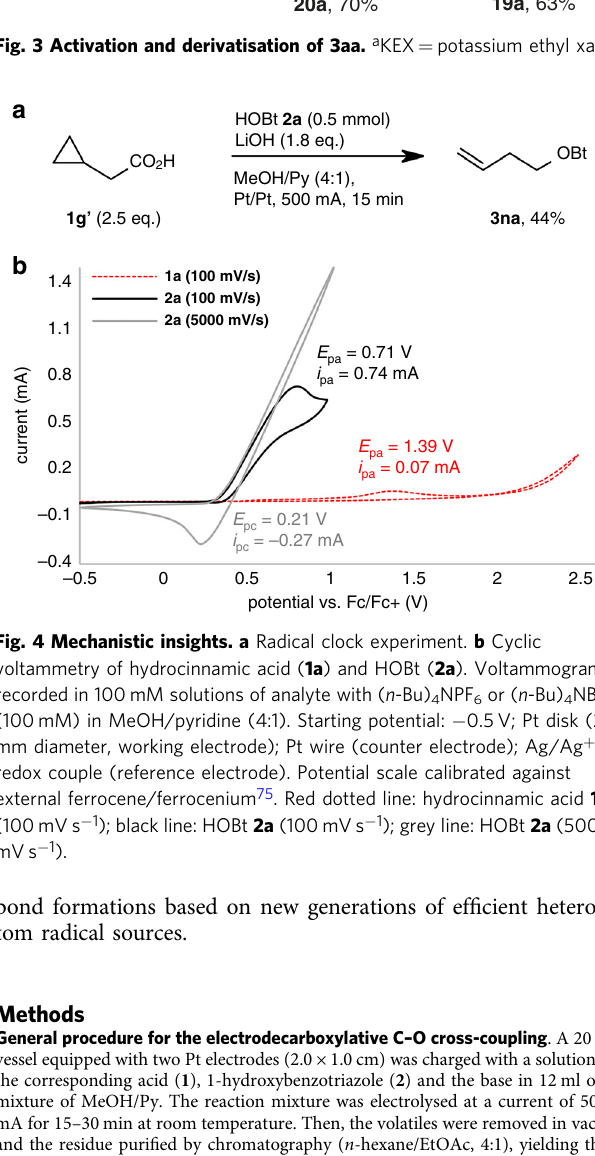
Methods General procedure for the electrodecarboxylative C – O cross-coupling . A 20ml vessel equipped with two Pt electrodes (2.0× 1.0cm) was charged with a solution of the corresponding acid ( 1 ), 1-hydroxybenzotriazole ( 2 ) and the base in 12 ml of a mixture of MeOH/Py. The reaction mixture was electrolysed at a current of 500 mA for 15 – 30min at room temperature. Then, the volatiles were removed in vacuo and the residue puri fi ed by chromatography ( n -hexane/EtOAc, 4:1), yielding the corresponding C – O coupling product 3 . Note: due to its explosive nature, HOBt was used exclusively in the form of its stable hydrate.